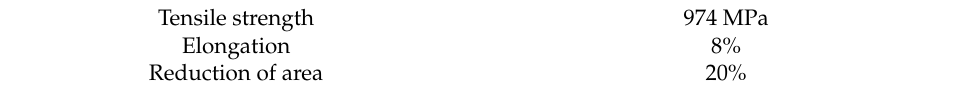
Table 2. Mechanical properties of the Ti6Al4V workpiece used in the experiments.